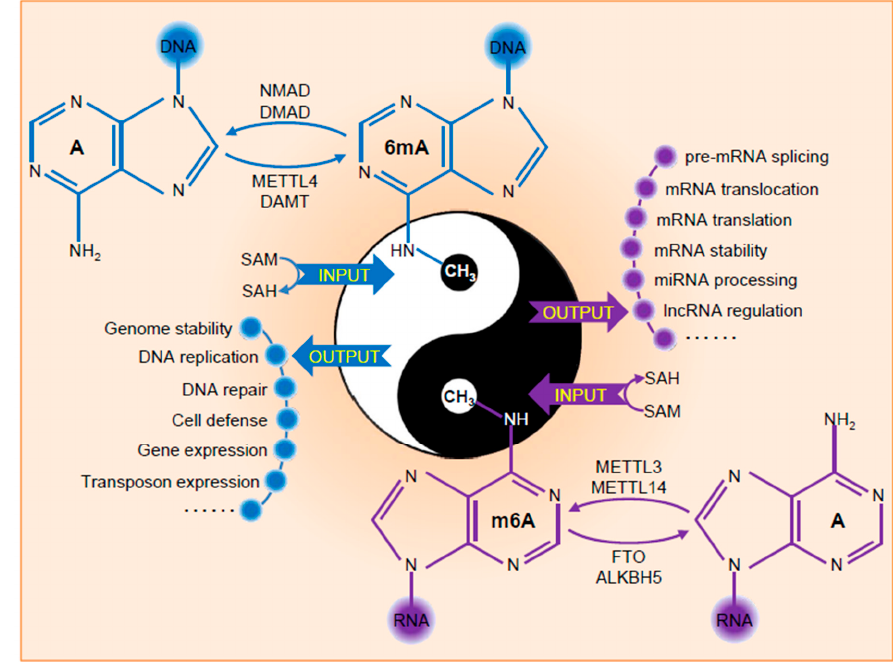
Figure 1. Modifications and functions of DNA 6mA and RNA m6A. Input represents the methylation process of adenine or adenosine by adding the methyl group to exocyclic NH2 at the sixth position of the purine ring through methyltransferase complex. Output exhibits the distinct functions of DNA 6mA and RNA m6A in multiple biological